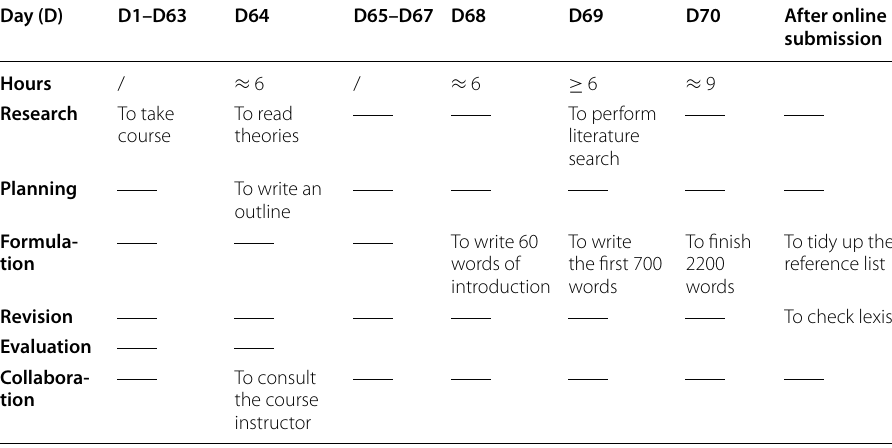
Table 3 Wei’s composing activities for the SEN essay Day